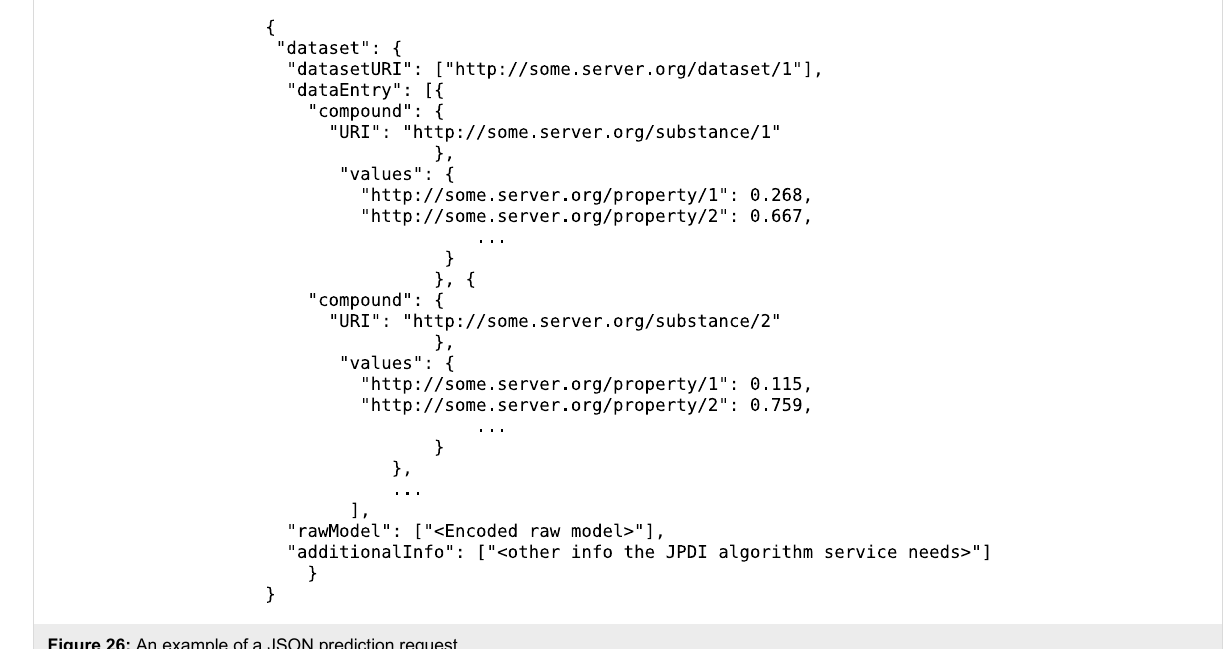
Figure 26: An example of a JSON prediction request.